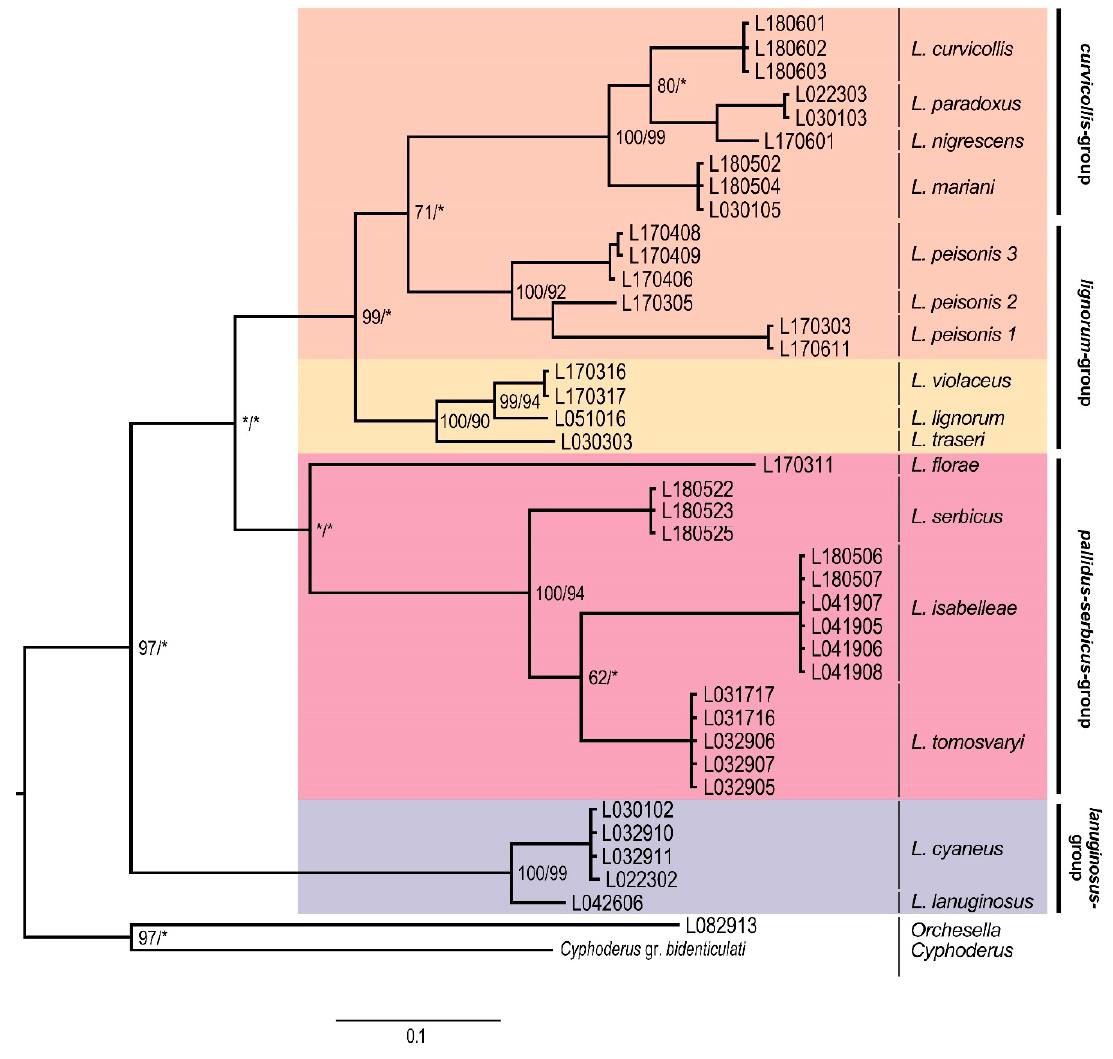
Figure 4. Bayesian consensus tree obtained based on the EF1- α dataset. Numbers close to nodes denote Bayesian posterior probabilities / maximum likelihood bootstrap support. Asterisks (*) indicate posterior probabilities or bootstrap values less than 60%. Morphological groups are labeled in bold.